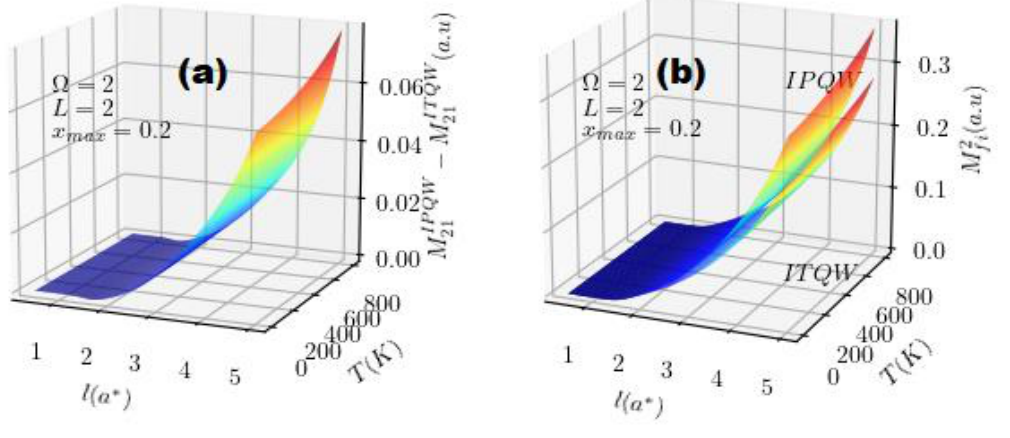
Figure 4: The variation of the electric dipole transition moment between both of them (ITQW and IPQW) (a) and that of them separately (b) versus the well width (x-axis) and temperature (y-axis) with a fixed barrier width (L=2) and x =0.2 and max